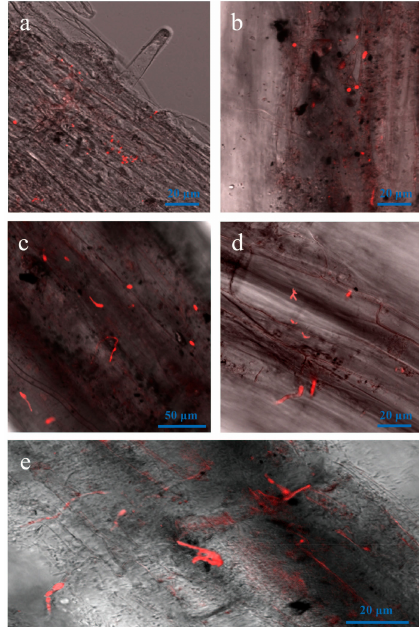
Figure 4. Laser scanning confocal microscope (LSCM) of root surface of Nicotiana benthamiana from one to three days after inoculation with the Vd-m strain. ( a , b ) Spores at one dpi; ( c , d ) Germ tubes at two dpi; ( e ) Elongating hyphae at three dpi.